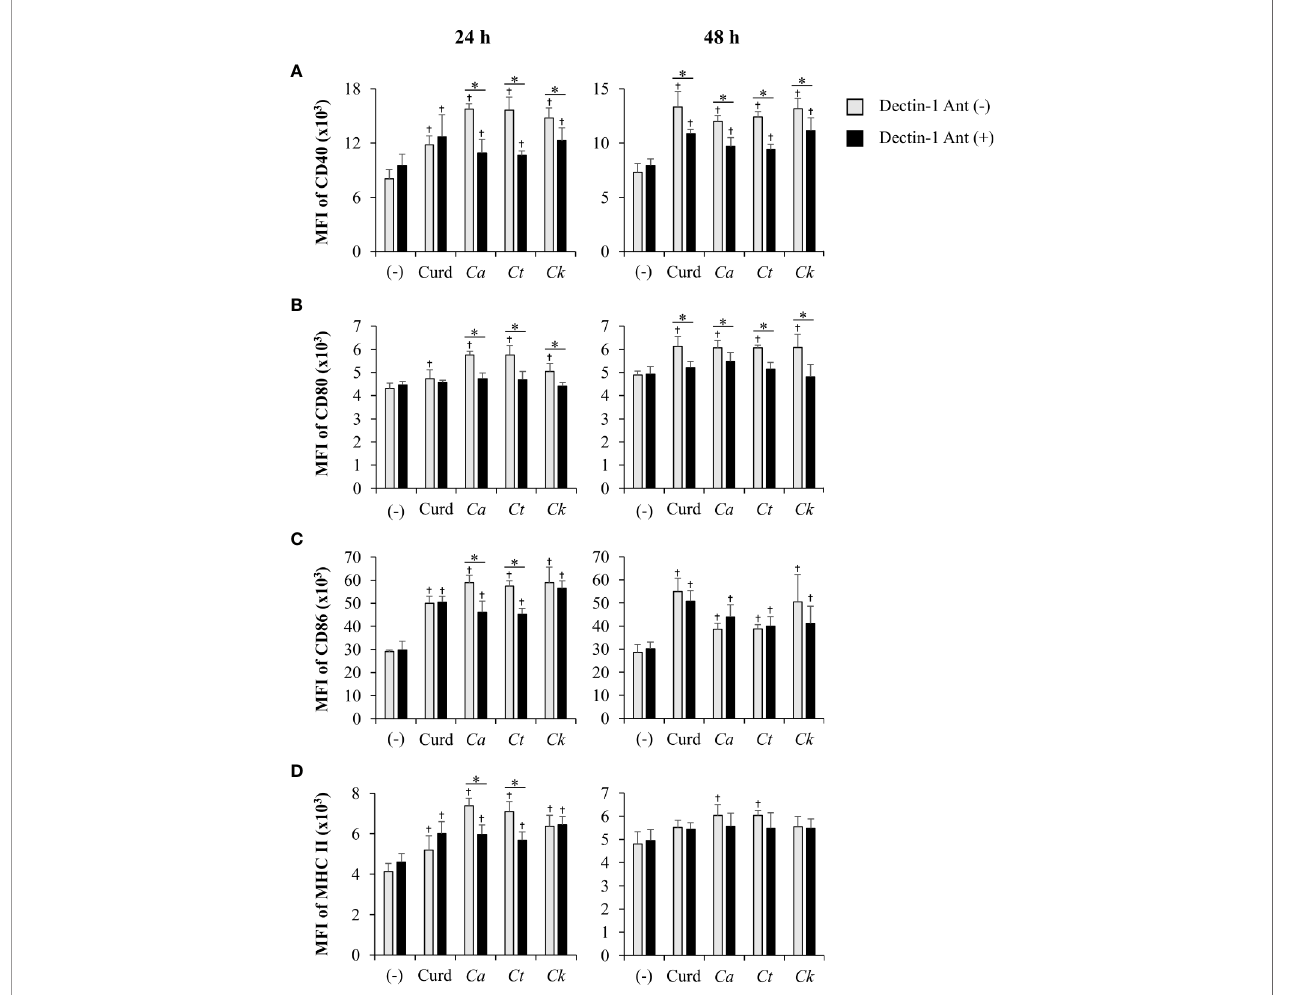
FIGURE 9 | Inhibition of dendritic cell (DC) maturation by dectin-1 blockade. Bone-marrow derived DCs (BMDCs) were pre-treated with 25 µg/ml of dectin-1 antagonist for 2 h, and then the cells were stimulated with 25 µg/ml of curdlan and b -glucans isolated from C. albicans , C. tropicalis , and C. krusei for 24 h and 48 h. The geometric mean fl uorescence intensity (MFI) of DC maturation markers (A) CD40, (B) CD80, (C) CD86, and (D) MHC class II on CD11c + cells were determined using histogram analyses. n = 5; data are representative of two independent experiments. † p < 0.05 compared with unstimulated BMDCs, * p < 0.05. (-), unstimulated BMDCs; Curd, curdlan; Ca , C. albicans ; Ct , C. tropicalis ; Ck , C. krusei